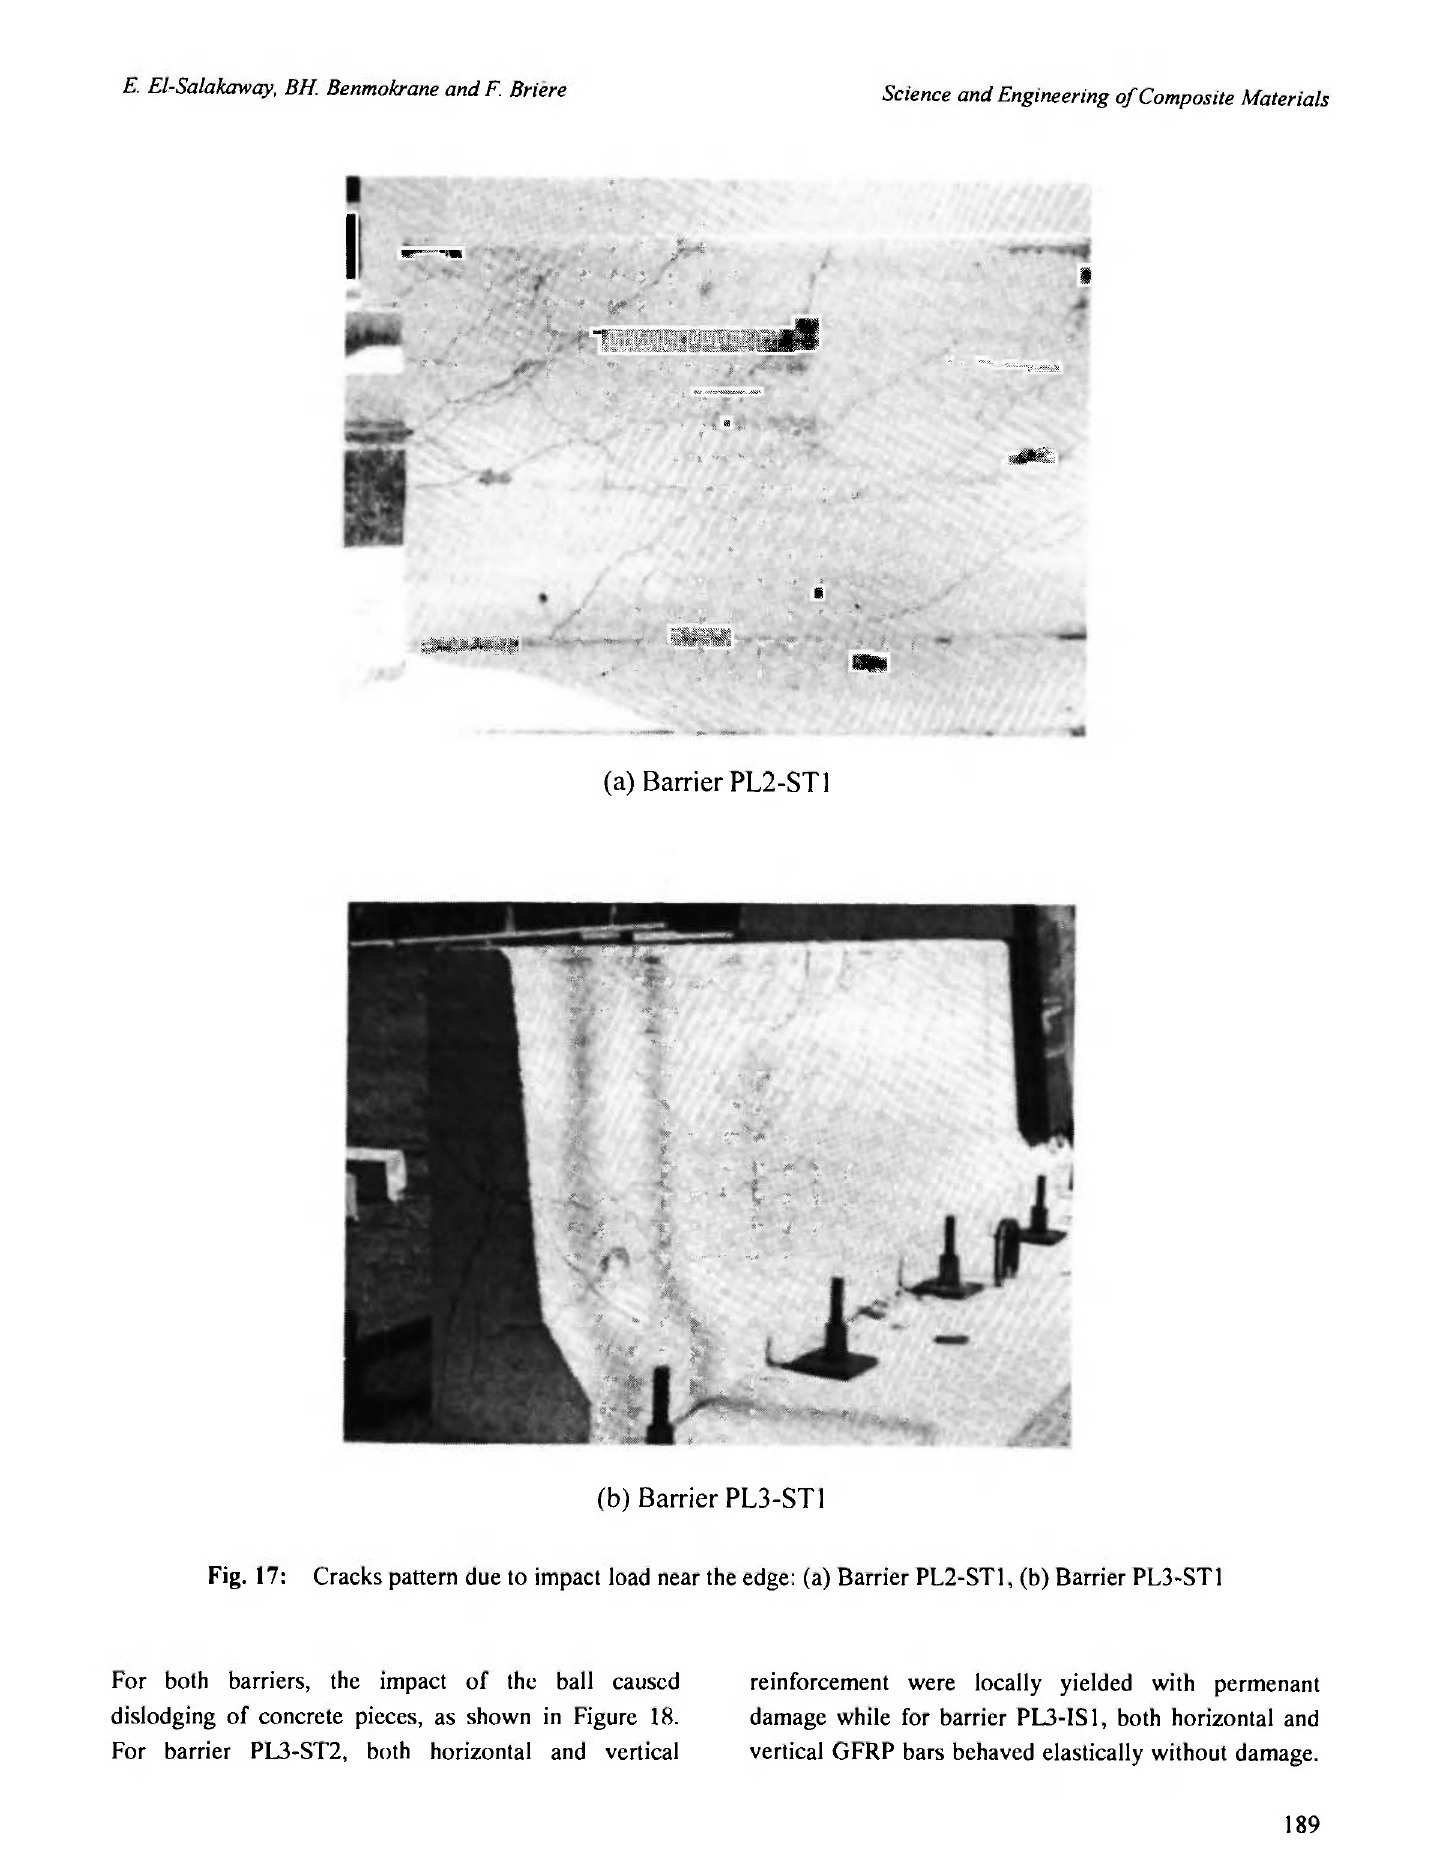
For both barriers, the impact of the ball causcd dislodging of concrete pieces, as shown in Figure 18. For barrier PL3-ST2, both horizontal and vertical